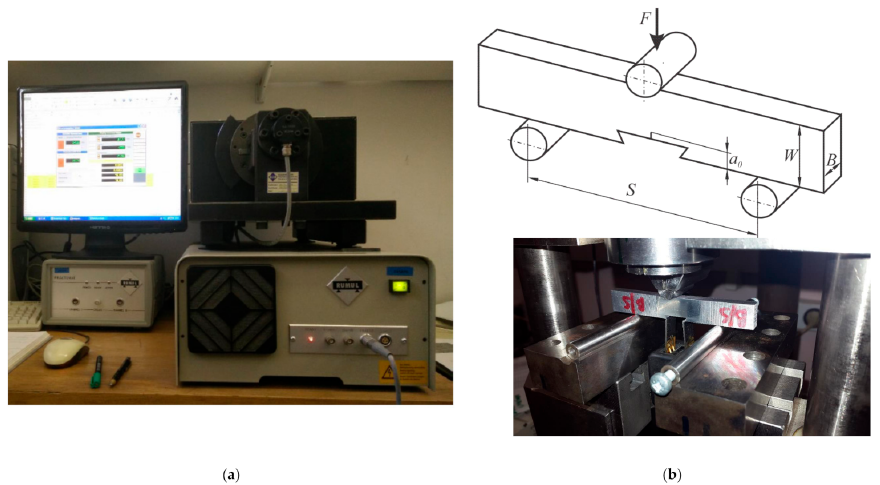
Figure 5. ( a ) Fracture toughness testing setup on a Rumul Cracktronic; ( b ) bend test fixture design. (Specimen: B —width; W —height; a 0 —initial crack size; S —support distance; F —load).